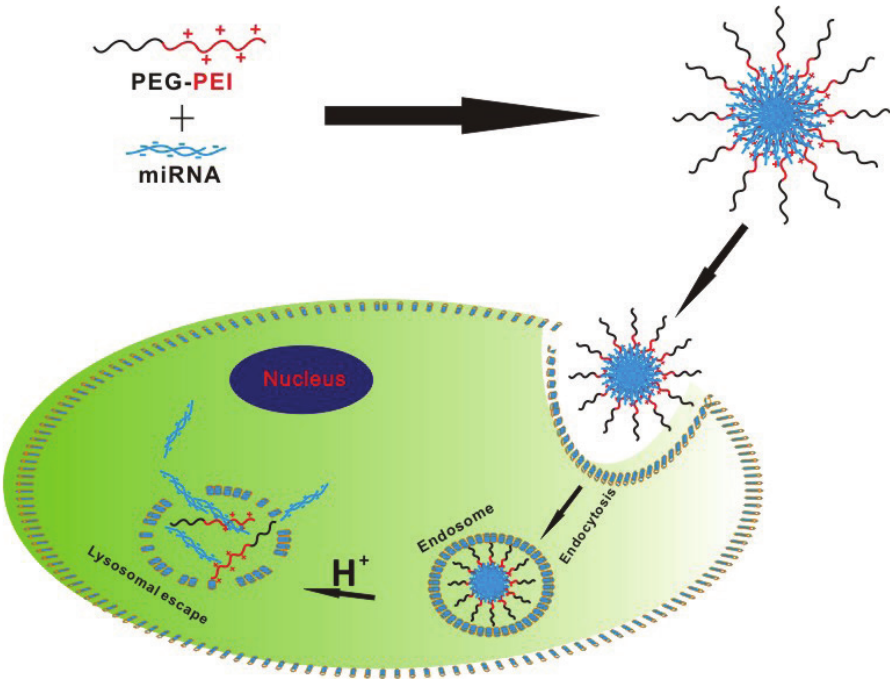
Figure 1: Schematic illustration of nanoparticle formation and internalization into PCa cells for co-delivery of